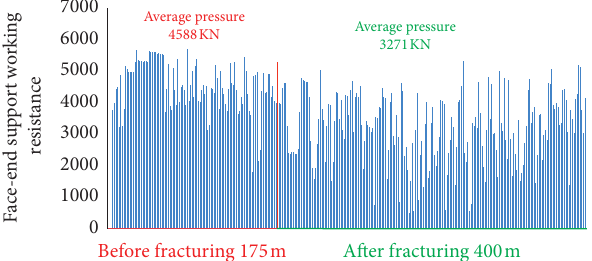
Figure 8: Working resistant of face-end support before and after